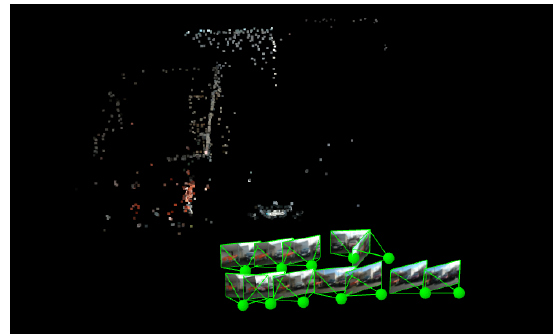
Figure 8. Image canvas for the calibration